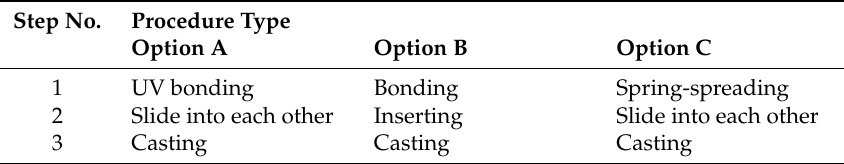
Table 2. Three possible options for how to resolve exemplarily the procedure type based on the user-given assembly sequence model of Figure